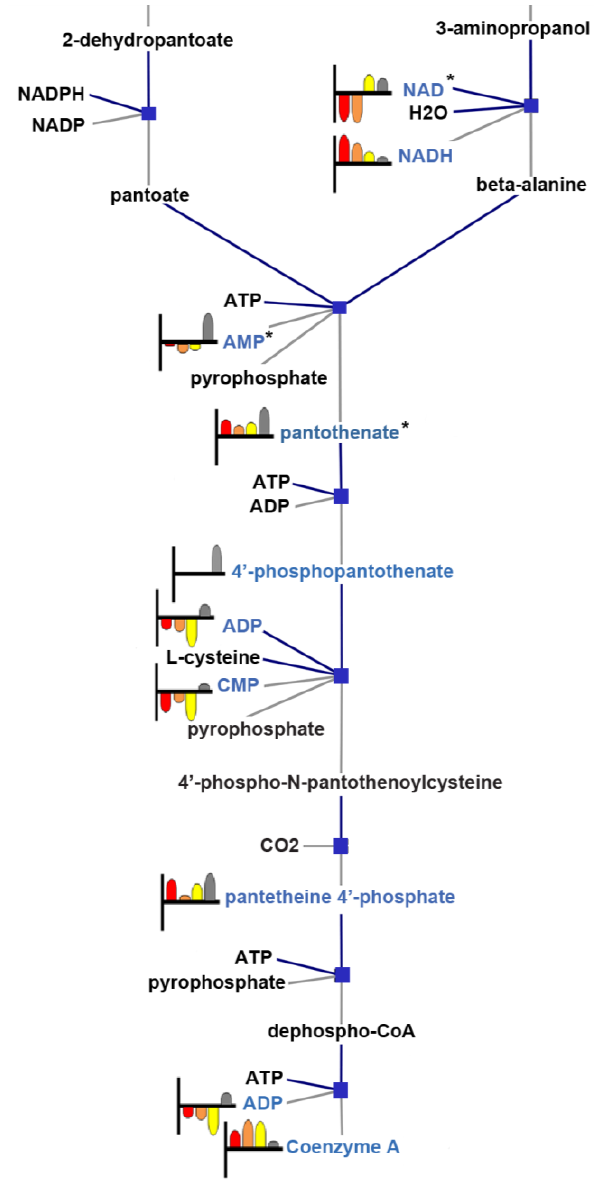
Figure 5. A portion of the pantothenate and coenzyme A biosynthesis pathway rendered from YeastCyc and enriched with the annotated features and MS/MS ( * ) identified compound results. The metabolites detected are highlighted inblue and accompanied by a heat strip that shows log2 normalized relative abundance, as detected per treatment condition; from left to right: calcium, red; CsA, orange; FK506, yellow; wild-type, grey. Boxes indicate gene/enzyme interaction nodes, which represent the genes described, but not